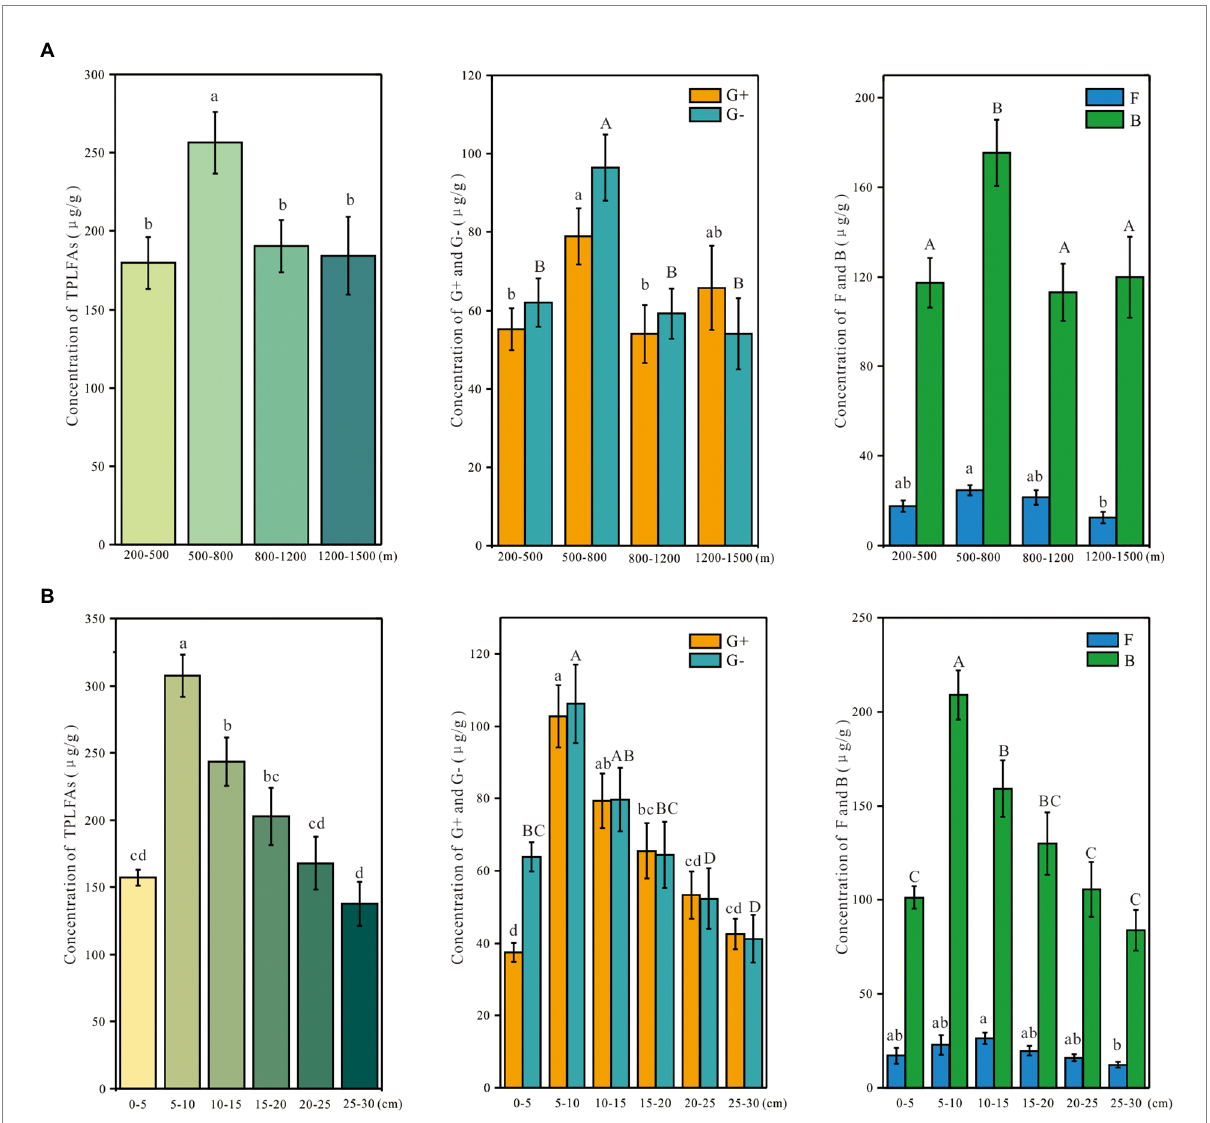
FIGURE 2 Concentration of various microbial groups based on the phospholipid fatty acids along the depth (A) and altitudinal (B) gradient on Changbai Mountain, China. Values were shown as Means ± SE. Different letters suggest significant differences among study sites based on one-way ANOVA and Tukey’s test ( p < 0.05). TPLFAs: total phospholipid fatty acids abundance; G+: gram-positive bacteria; G − : gram-negative bacteria; F: fungi; B: